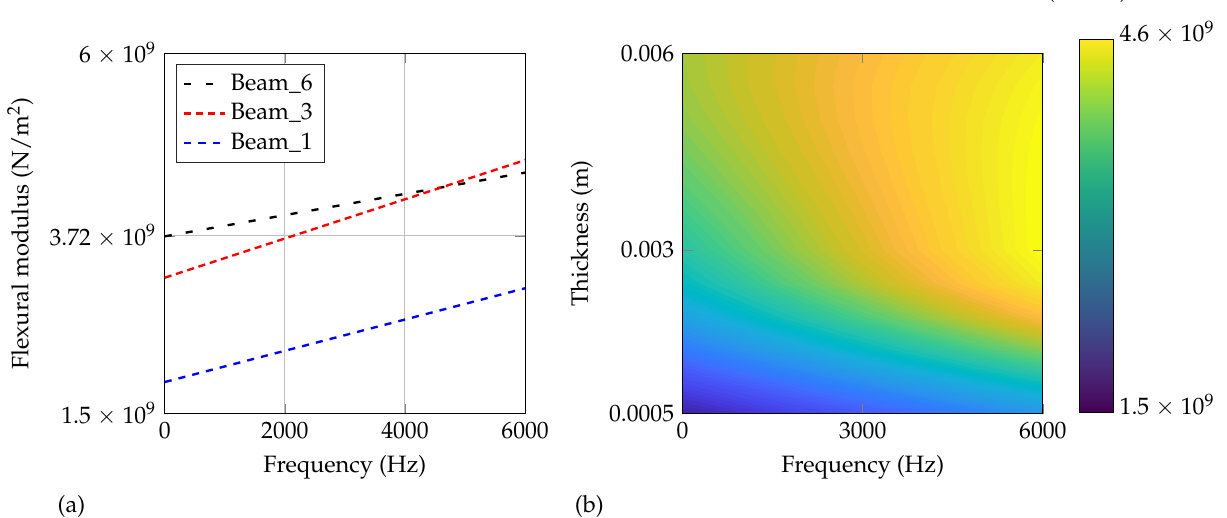
Figure 16. Overall fitted ( a ) linear curves for the three different manufactured thicknesses and ( b ) flexural modulus in dependency on frequency and thickness.